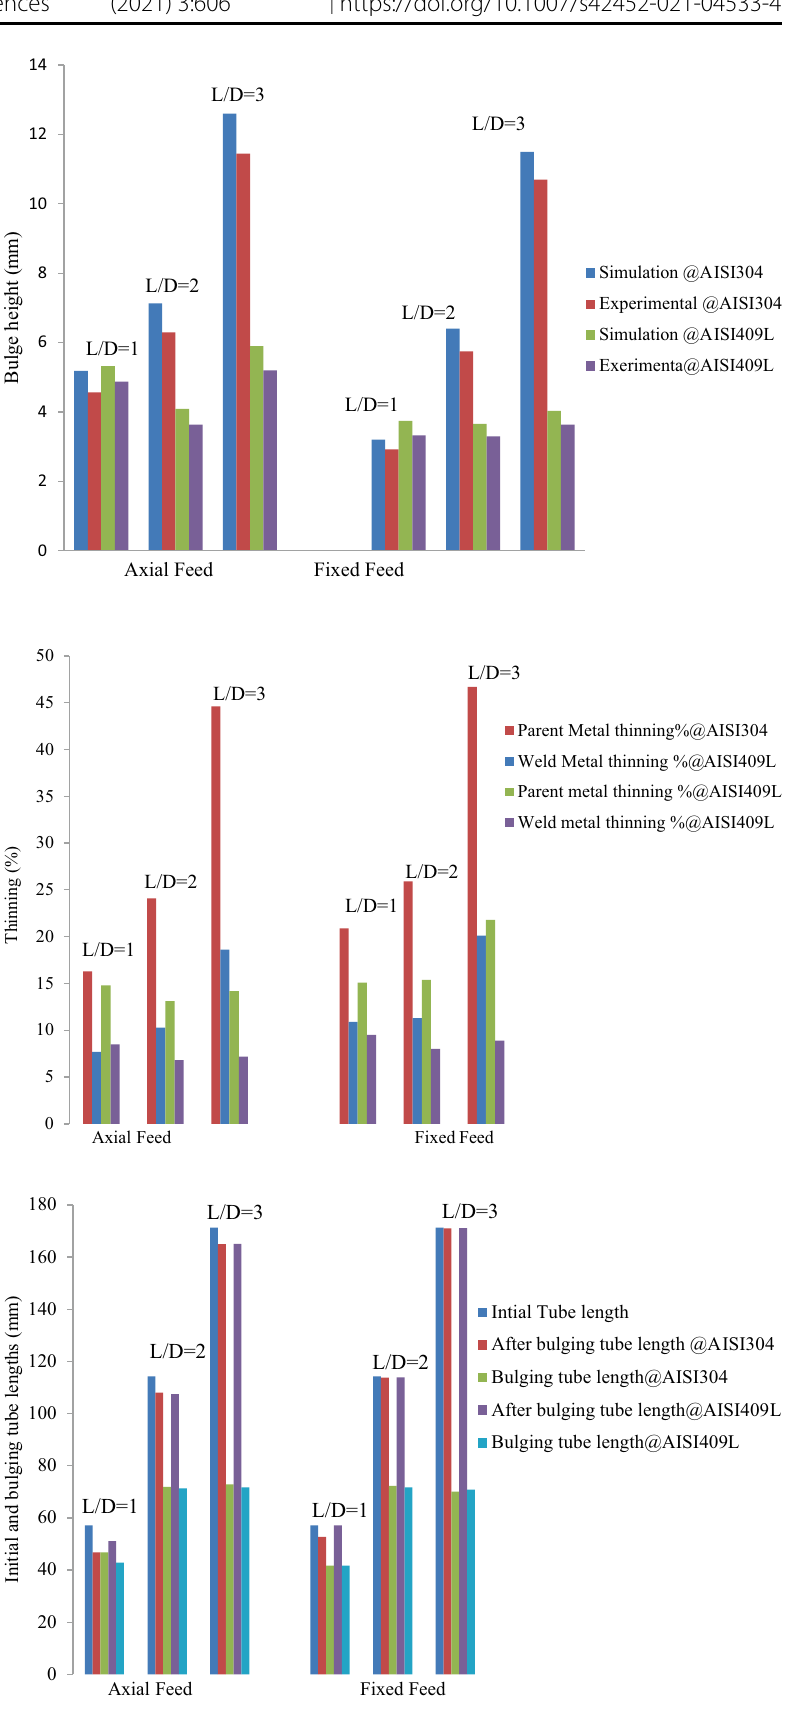
Fig. 15 Axial and fixed feed versus bulging